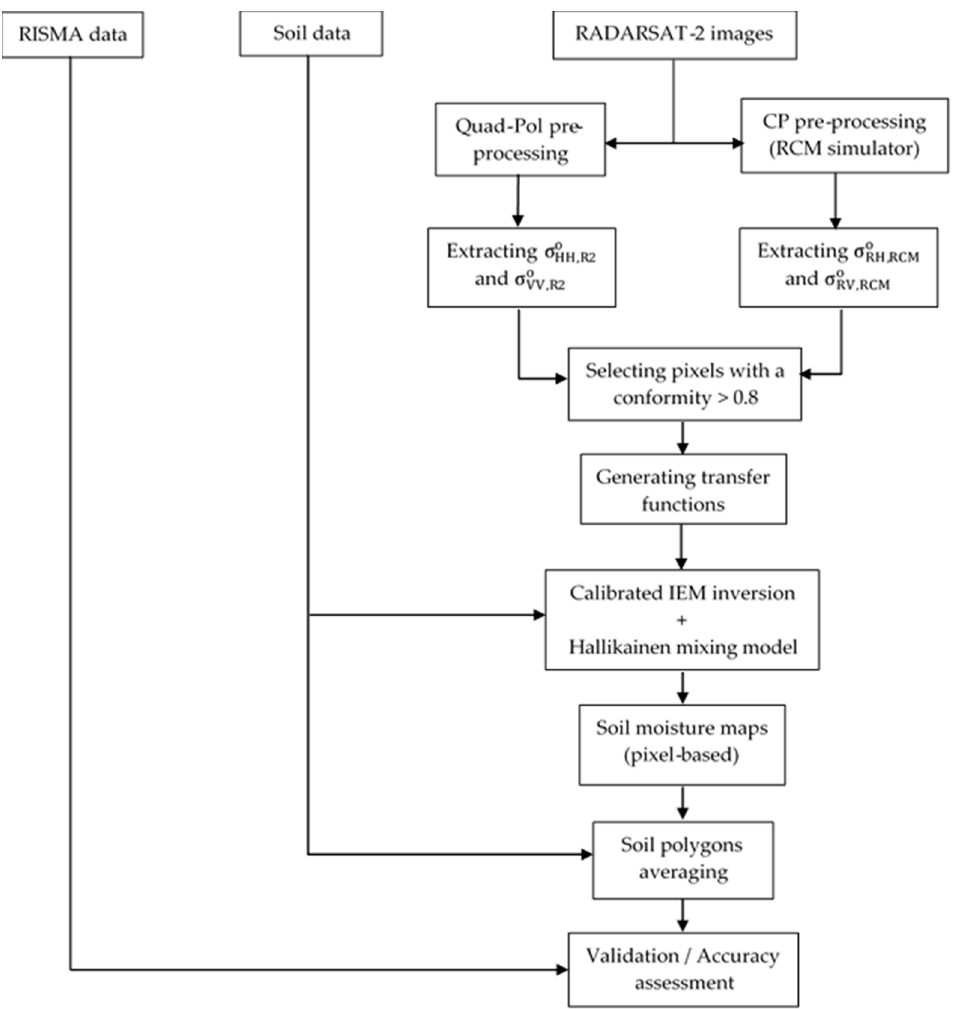
Figure 3. The flowchart of the proposed Compact Polarimetry (CP) method to retrieve soil moisture.